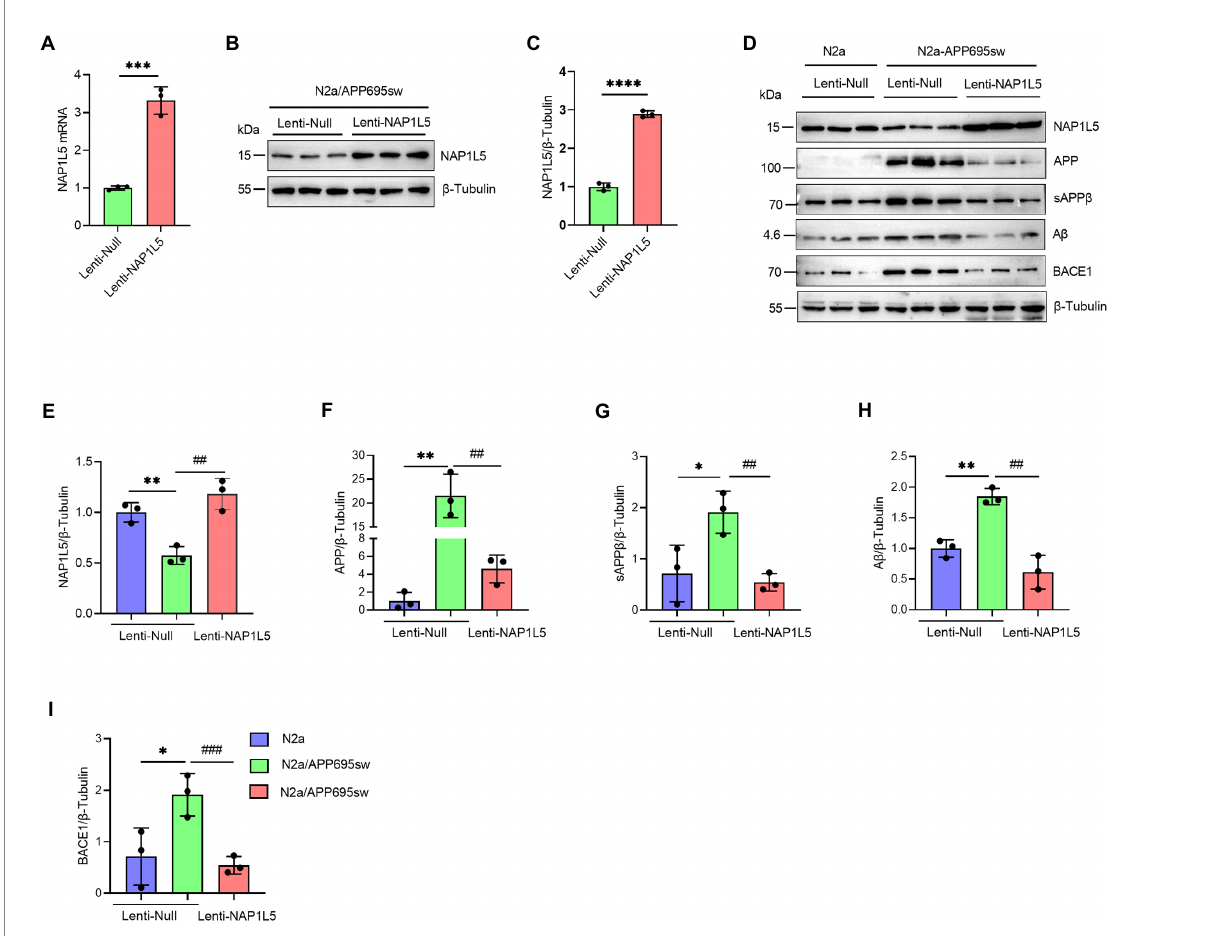
FIGURE 2 NAP1L5 overexpression inhibited APP metabolism in N2a-APP695sw cells. (A–C) N2a-APP695sw cells were stably infected with lenti-Null and lenti-NAP1L5, and the mRNA and protein levels of NAP1L5 were detected using RT-qPCR and Western blotting, respectively. Data are presented as mean ± SD, n = 3. ∗∗∗∗ p < 0.0001; Student’s t -test. (D – I) N2a or N2a-APP695sw cells were stably infected lenti-Null or lenti-NAP1L5. APP metabolism- related protein levels were detected using Western blotting (D) , and then quantified (E–I) . Data are presented as mean ± SD, n = 3. ∗ p <